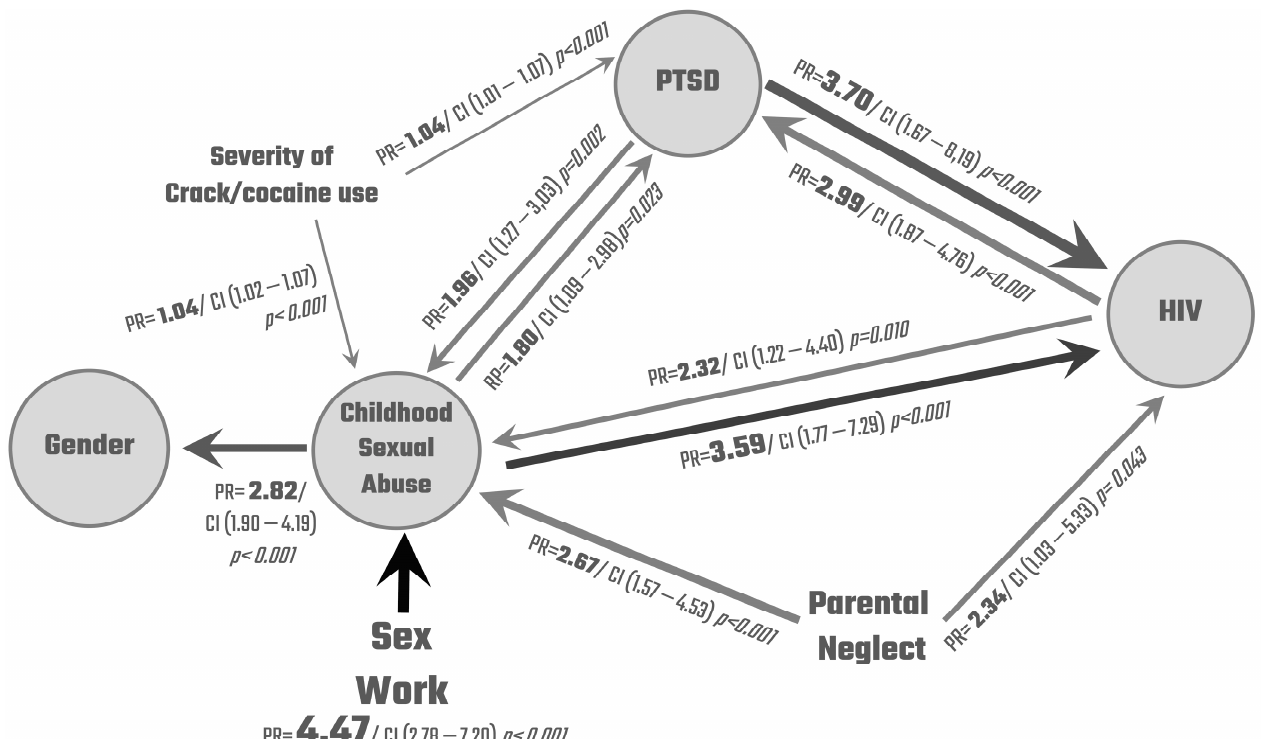
Figure 1. Flow Figure 1. Flow chart.